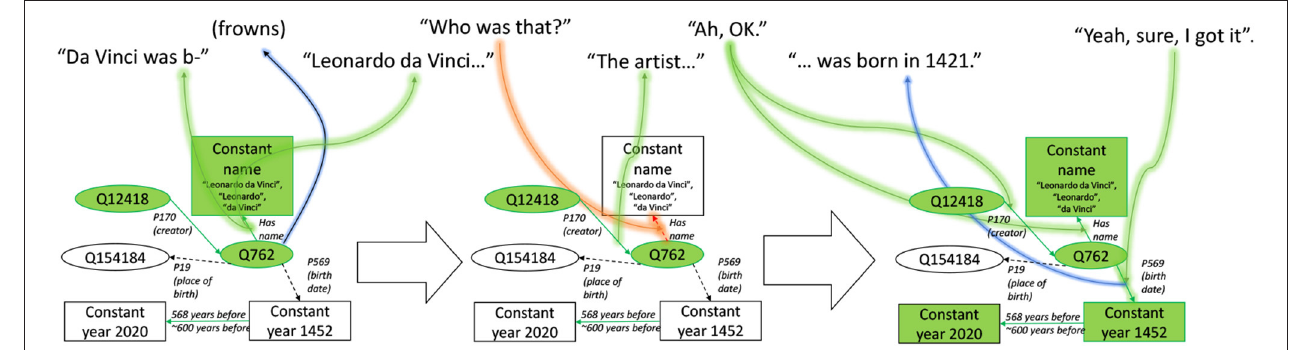
FIGURE 2 | An example of the knowledge graph approach for grounding mentioned in Section 4.2.3, adapted from Axelsson and Skantze (2020).